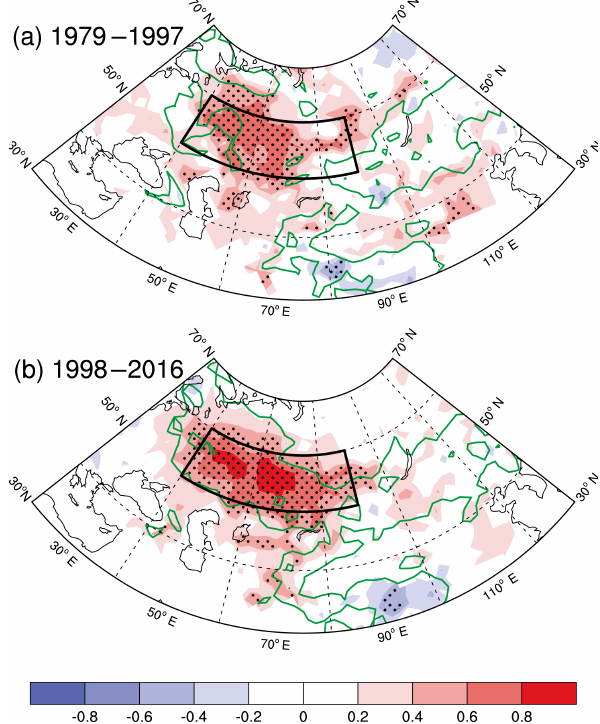
Figure 2. The CC between the SC ES and snow cover (a) from 1979 to 1997 and (b) from 1998 to 2016. The black dots indicate that the CC exceeded the 95% confidence level ( t test). The black box represents the ES area. The linear trend is removed. The green lines indicate that the interannual variations in snow cover were obvious in this